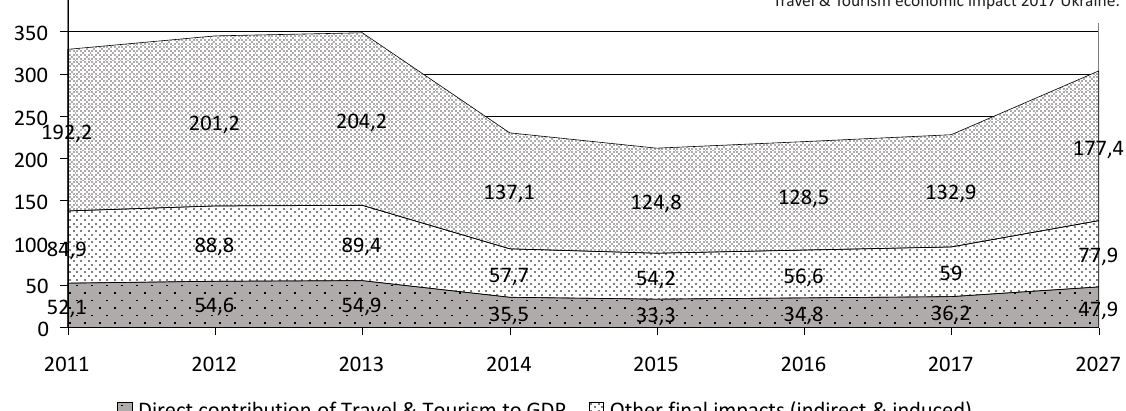
Figure 5. Economic contribution of the national tourism system to the GDP of Ukraine in 2011–2027 (billion UAH, real prices,